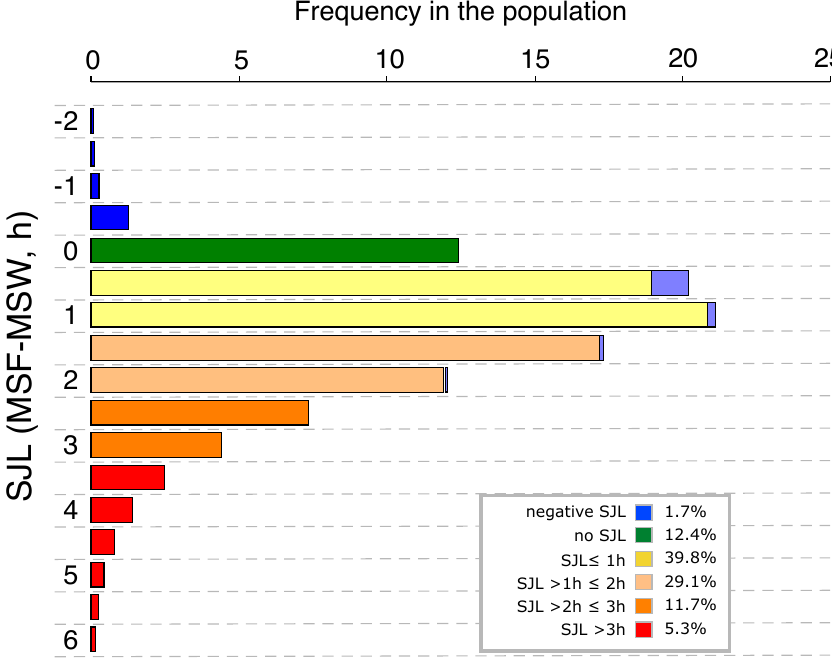
Figure 4. Distributions of social jetlag (SJL) in the Munich ChronoType Questionnaire (MCTQ) database (as of July 2017). The distribution is based on half-hourly bins (population as described in Figure 1 for midsleep on free days sleep corrected (MSF sc )). Color-coding is arbitrary and classifies the population into the six SJL groups indicated in the legends. To signify the distribution of the absolute version of SJL (see text for details), the negative SJL categories are mirrored as light blue extensions of the respective positive SJL